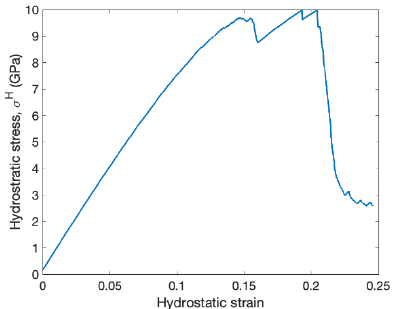
Figure 5. Hydrostatic stress-strain curve from a molecular statics simulation of delamination at T = 0 K. The peak stress is the stress required to delaminate the particle without the aid of thermal fluctuations.